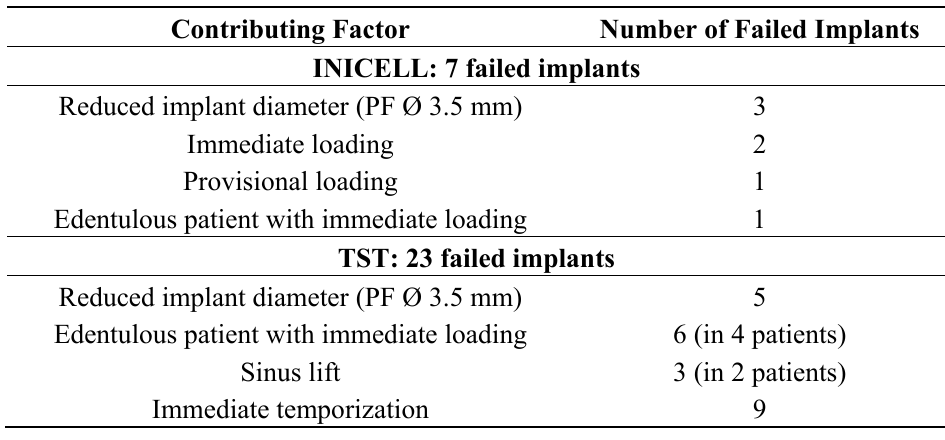
Table 2. Factors contributing to implant